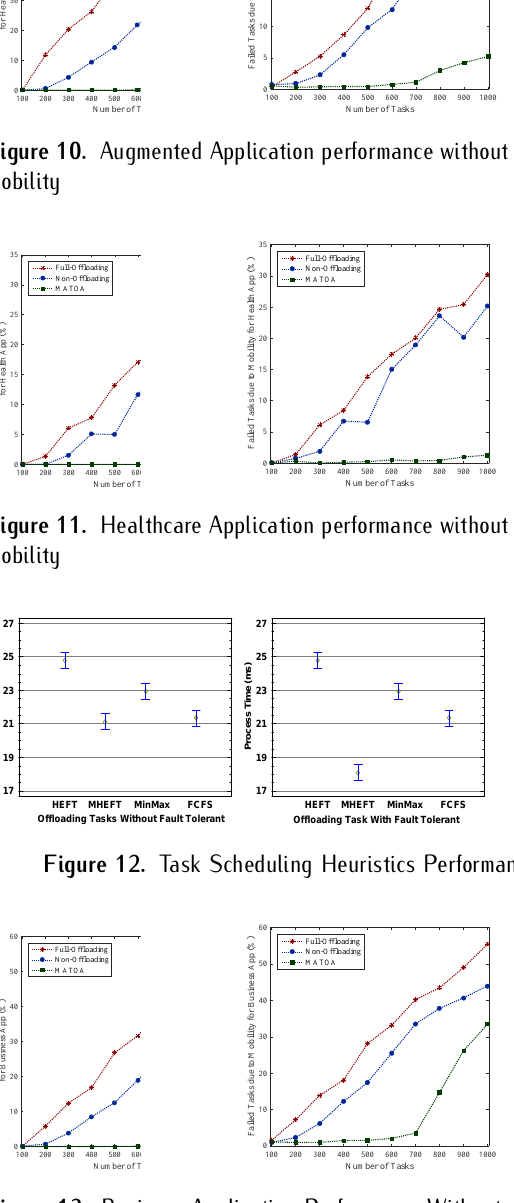
performance of the MATOA more fairly as compared to literature task o ffl oading approaches. Fig. 12 shows that our modified heuristics are getting lower overhead as compared to existing heuristics, this is because mobile cloud application cannot directly accept the traditional